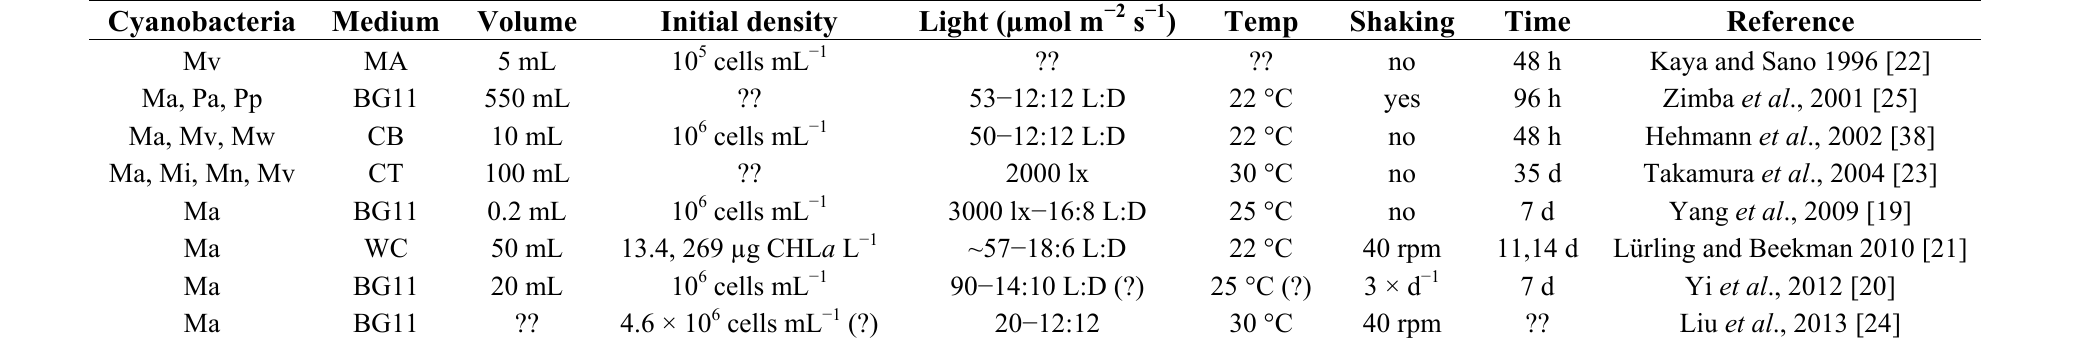
Table A1 . Overview of experimental conditions, such as medium type, volume of experimental units, inoculum densities, light regime (intensity–light dark regime), temperature, shaking and duration, of studies performed to investigate the effect of plant extracts or lysine on growth of cyanobacteria. Mv = Microcystis viridis , Ma = M. aeruginosa , Mw = M. wesenbergii , Mi = M. ichthioblabe, Mn = M. novacekii , Pa = Pseudanabaena articulata , Pp = Planktothrix perornata